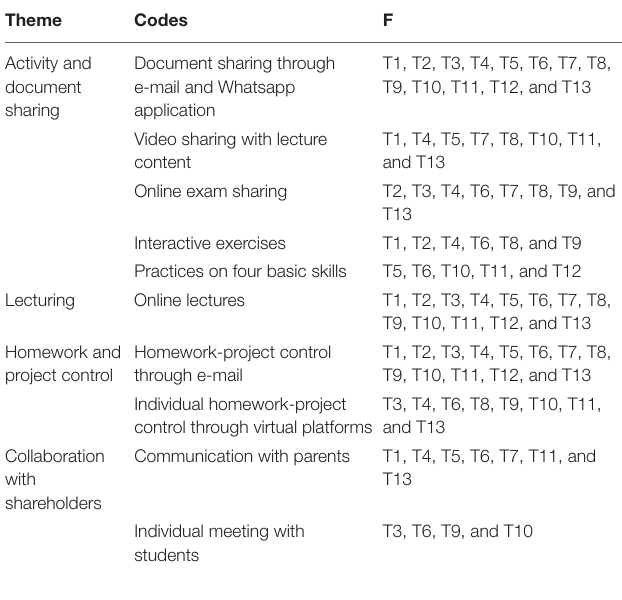
TABLE 2 | Distance education activities of